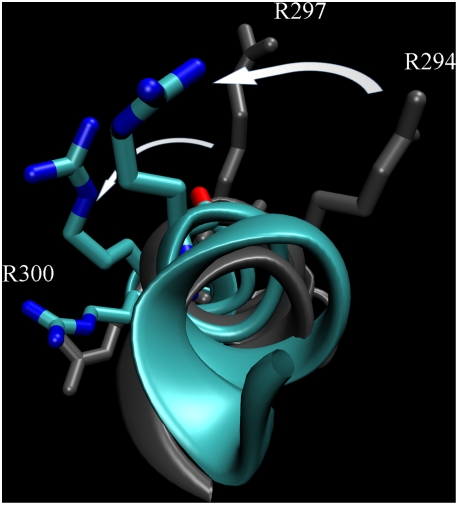
Rotation of the S4 helix in subunit C.An extracellular view of the S4 helix at the beginning (gray) and end
(cyan) of the simulation. The top three arginines in each conformation
are shown in stick representation and the large counter-clockwise
rotations of R294 and R297 indicated by arrows. The end-conformation was
been aligned to the initial using the Cα atoms in helices S1 to
S3 after which the S4 helices were aligned to each other in order to
compare their relative rotation.